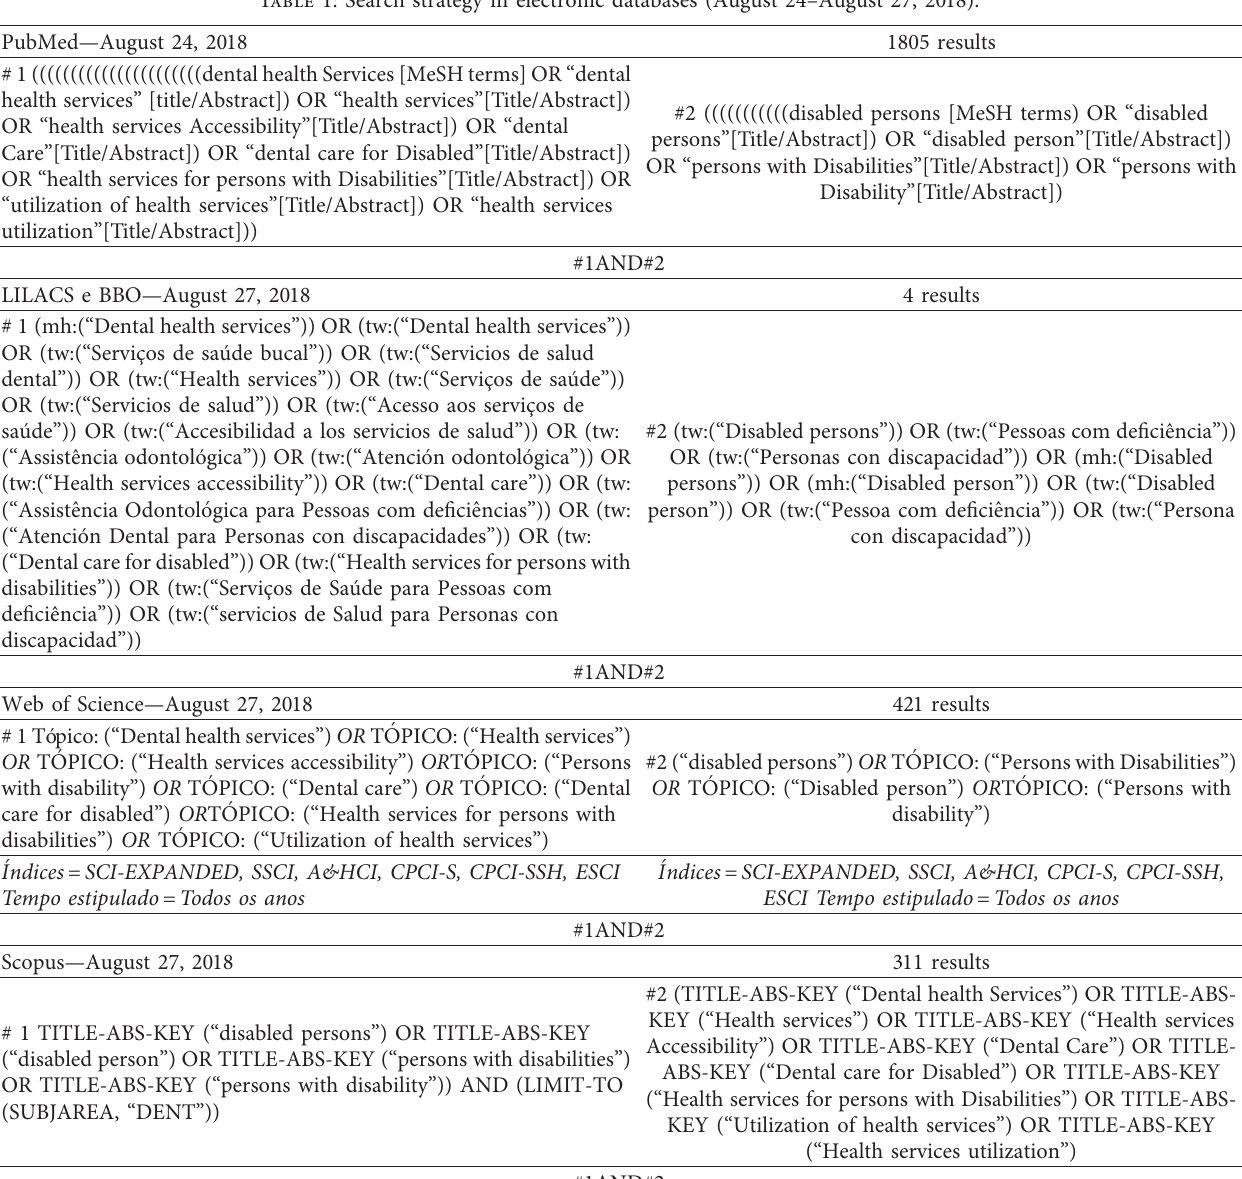
Table 1: Search strategy in electronic databases (August 24–August 27,